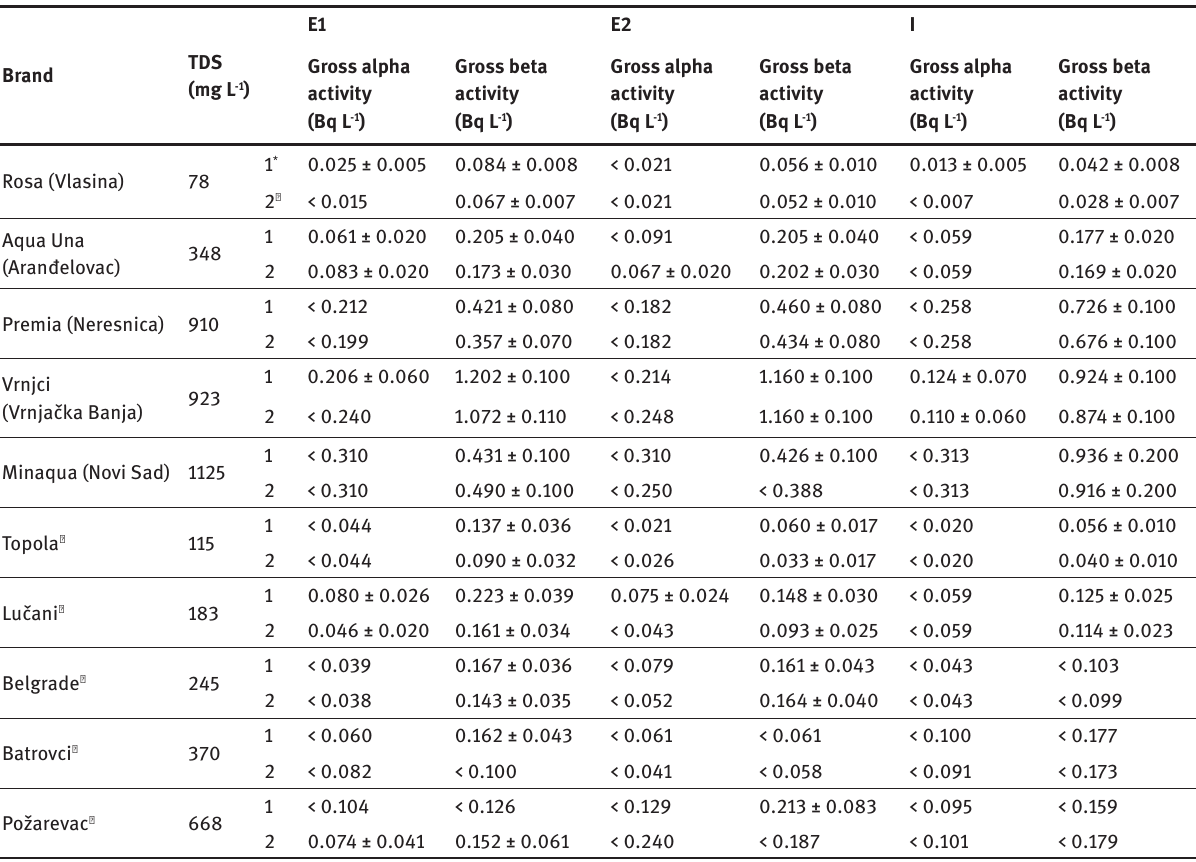
Table 2 : Summarized data on TDS, gross alpha and gross beta activity concentrations in waters using different methods. The results are presented as the mean value of five measurements.